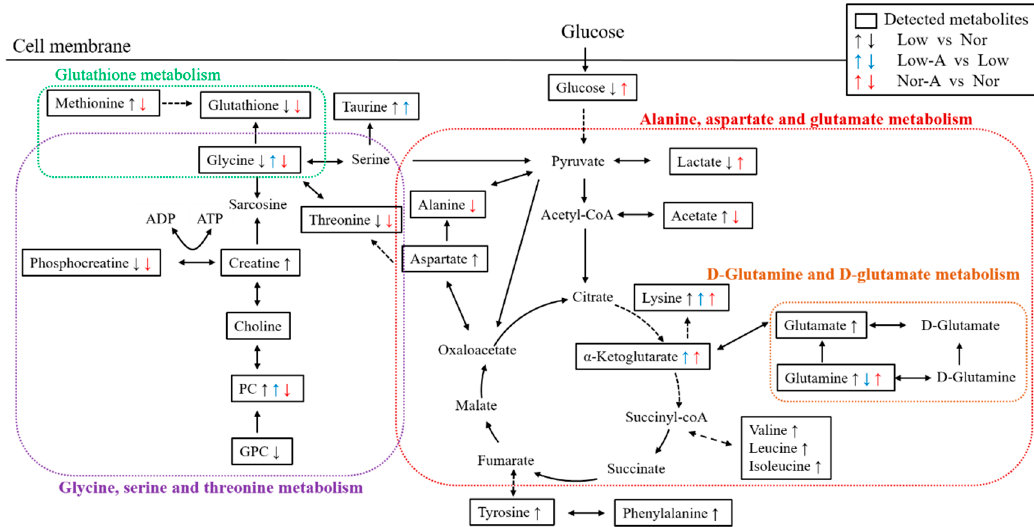
Figure 6. Schematic representation of significantly altered metabolic pathways identified from pairwise comparisons of Nor-A vs. Nor, Low vs. Nor, Low-A vs. Low. The up/down arrow highlights metabolites with significantly increased/decreased levels compared with the control group; dotted arrow indicates multiple biochemical reactions; solid arrow denotes a single biochemical reaction. The significantly altered metabolic pathways were identified based on the KEGG database using the MetaboAnalyst